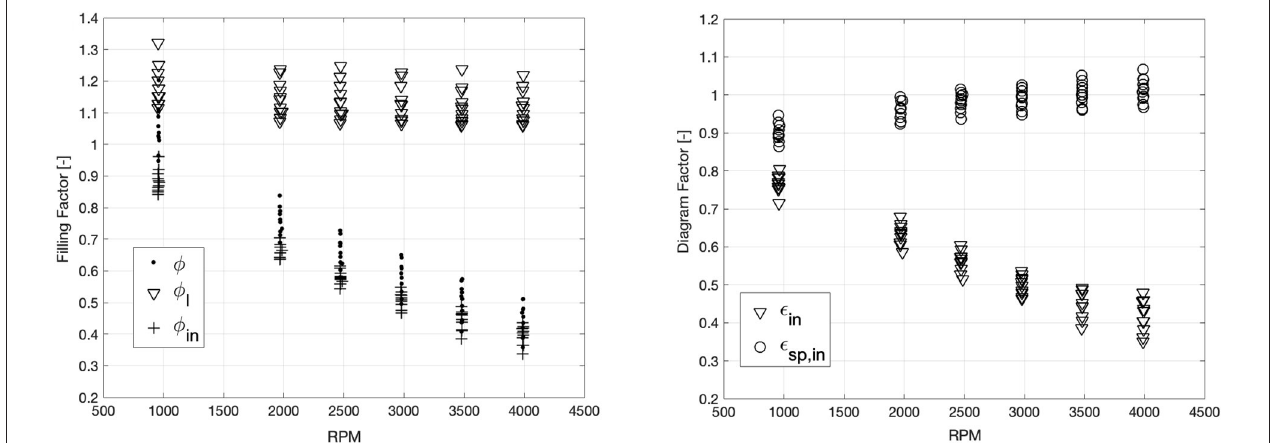
FIGURE 11 | (left) Filling Factor detachment in terms of rotational speed; (right) Diagram and specific diagram factors in terms of rotational speed.